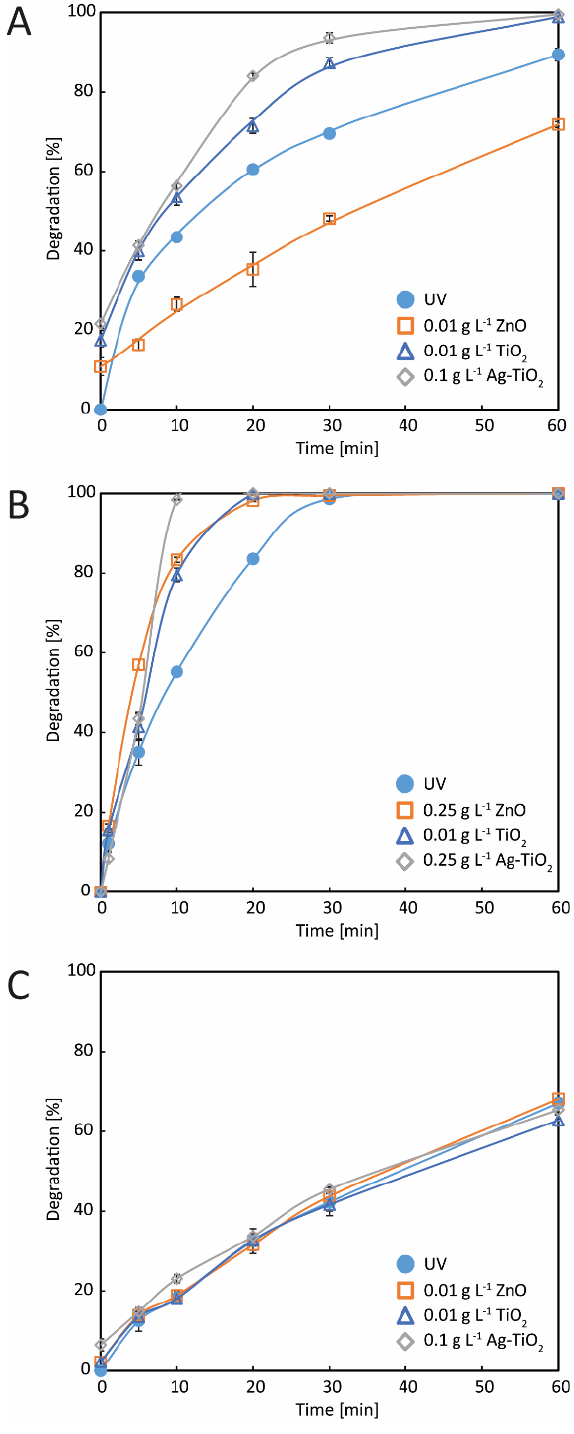
Figure 5. Comparison of the best degradation results obtained with the addition of three catalysts. ( A ) Degradation of BPA, ( B ) degradation of BPS, ( C ) degradation of FLC. The initial concentrations of BPA, BPS, and FLC were 10 mg L −1 .